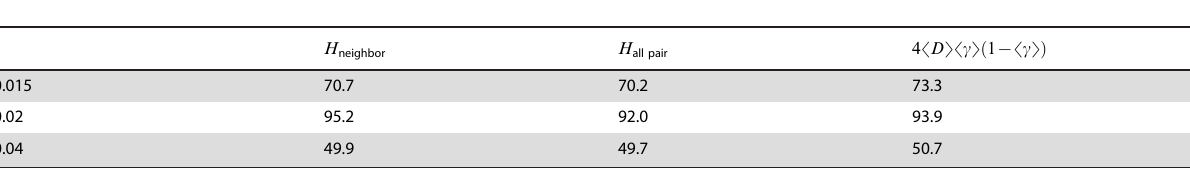
Table 1. Hamming distance in the high diversity state in quasi-static a N ? 0 case.